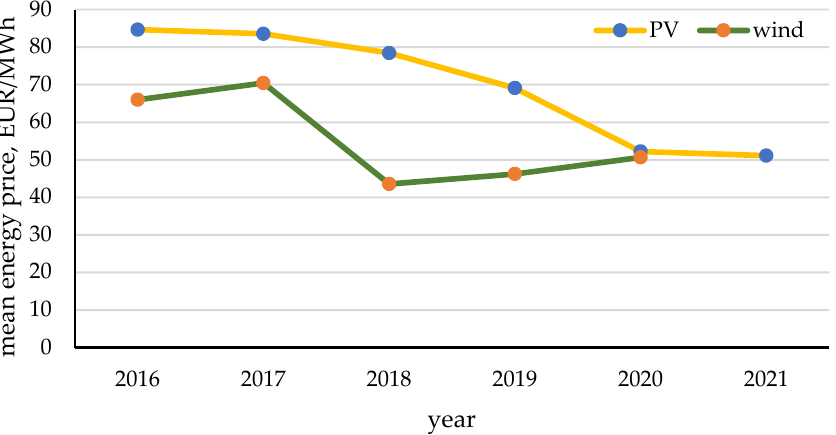
Figure 8. Average energy prices (weighted by the number of installations and energy volume) at the RES auction system (PV: 2017–2021 and wind: 2016–2020) auctions. Source: own study based on